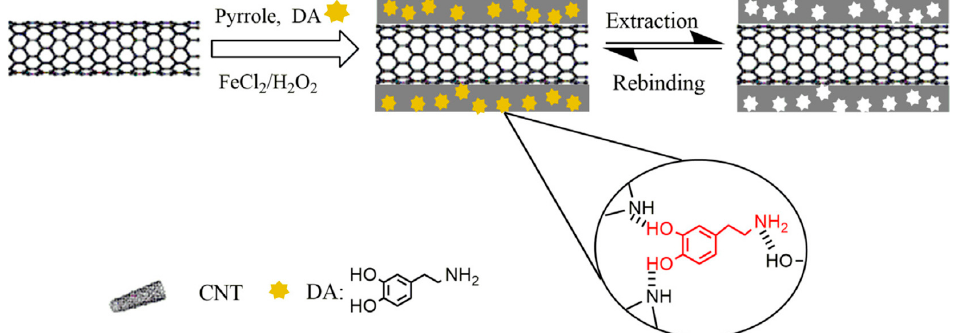
Figure 6. Chemical route for the preparation of molecularly imprinted polymer (MIP) polypyrrole (PPy)/ carbon nanotubes (CNTs). Reprinted with permission from reference [87]. Copyright © 2014 Elsevier B.V.